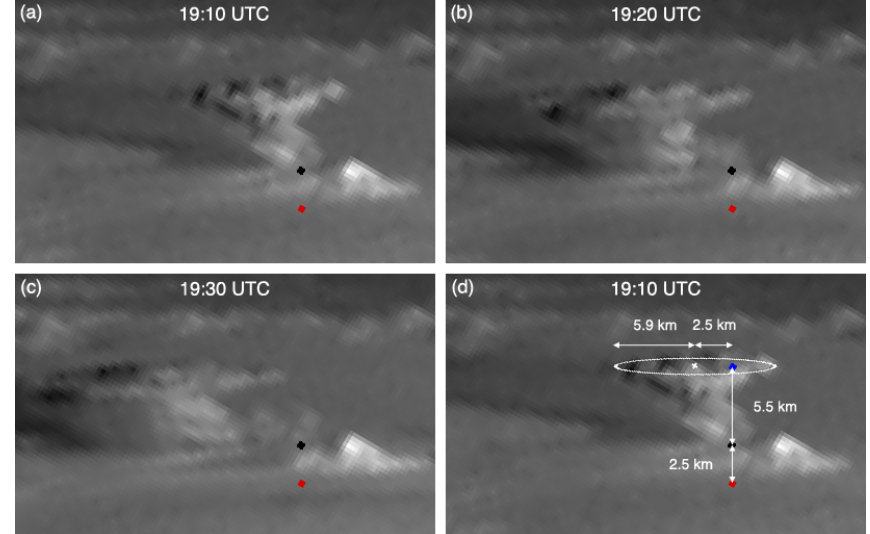
Figure 2. GOES-17 band 2 fixed grid image (8 × magnification) of the 8 April 2020 eruption of Sheveluch at (a) 19:10UTC, (b) 19:20UTC, (c) 19:30UTC, and (d) 19:10UTC with plume geometry indicated. The images were rotated clockwise by the geodetic colatitude angle; south is left, north is right, west is up, and east is down. The red and black diamonds respectively mark the base and vent of Young Sheveluch. In panel (d) , the umbrella cloud is fitted with a circle of 5.9km radius (distorted into an ellipse in the fixed grid view), and the blue diamond is our best visual estimate plume top position above the